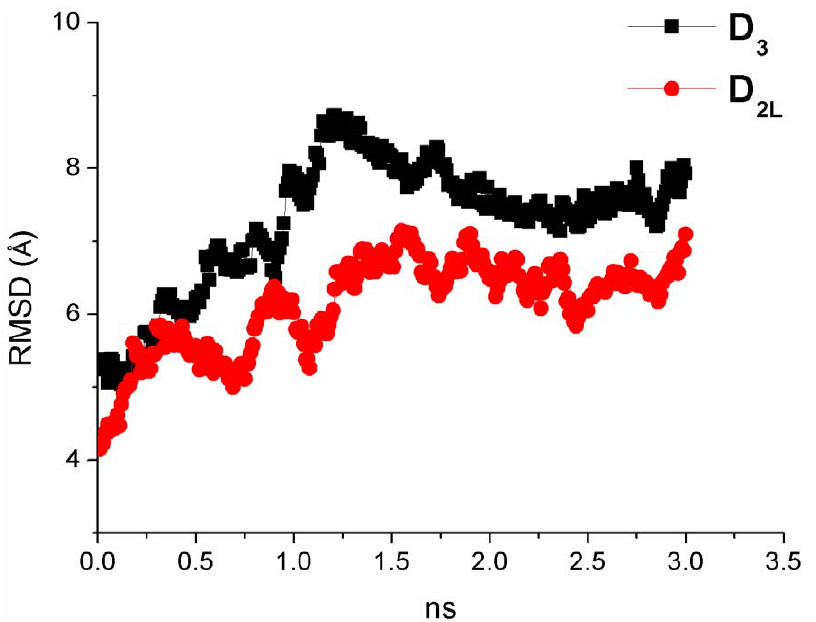
Figure 4. Analysis of Root Mean Square Deviation of C a atoms during molecular dynamics simulation. RMSD respect to the starting structures, homology models, of hD 3 (black squares) and hD 2L (red circles) receptors.